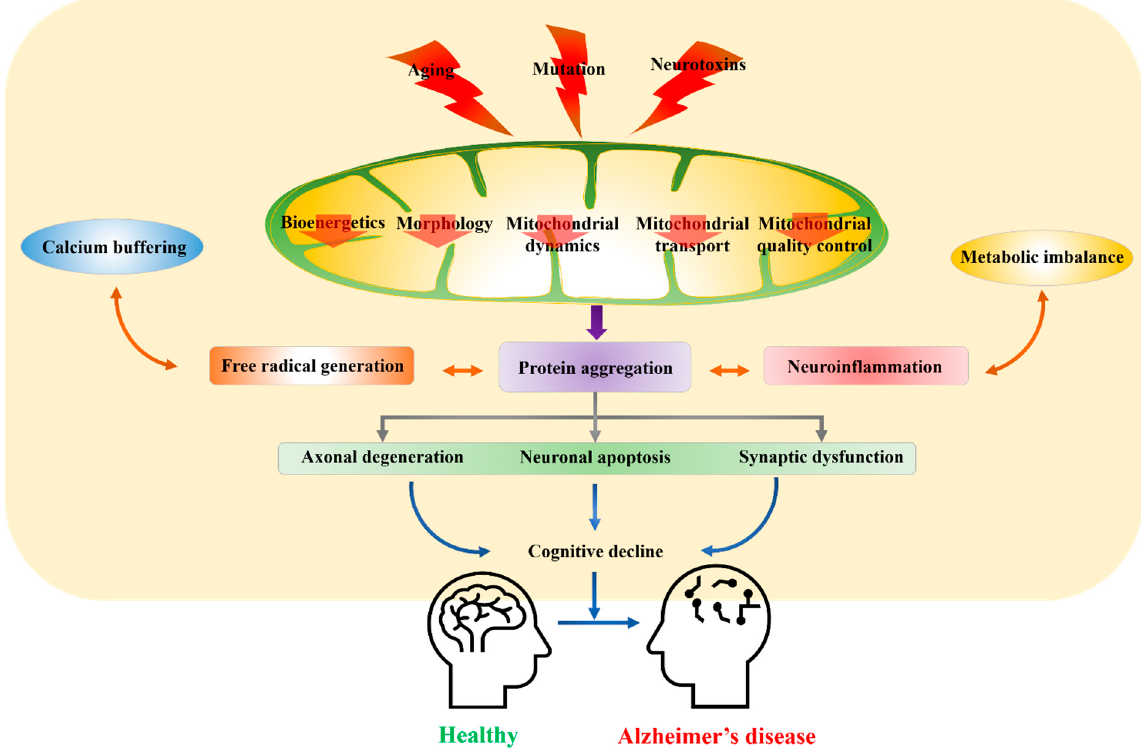
Figure 1. Mitochondrial dysfunction as a driver of cognitive impairment in Alzheimer’s disease (AD). Mitochondria are susceptible to various age-associated processes, mutations, and toxic insults such as metal exposure. Damaged mtDNA and other macromolecules accumulate during aging, leading to metabolic impairment. Resultant accumulation of damaged and dysfunctional mitochondria has been reported as an early sign preceding AD and contributing to disease progression. Dysfunctional mitochondria further cause bioenergetic deficiency, intracellular calcium dysregulation, and generation of free radicals leading to oxidative stress, thereby aggravating the effect of A β and tau pathology and further exacerbating mitochondrial damage, synaptic dysfunction, cognitive impairment, and memory loss.